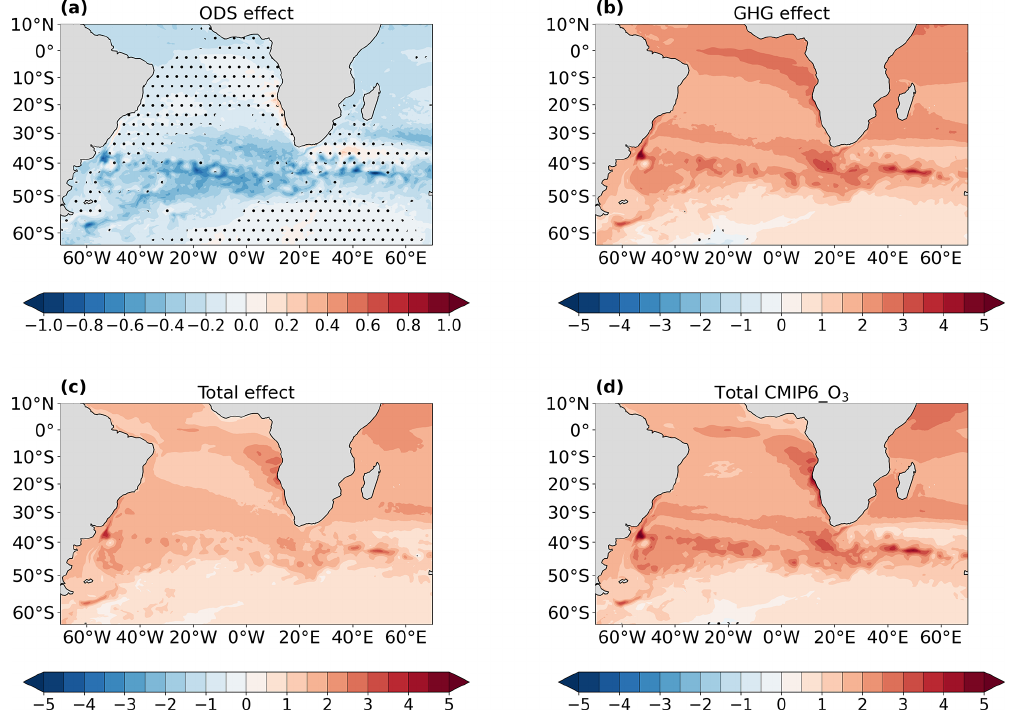
Figure 17. Changes in the SST ( ◦ C) for the region covered by the high-resolution nest (63 ◦ S–10 ◦ N and 70 ◦ W–70 ◦ E): effect of ozone recovery (a) , effect of GHGs (b) , total effect in INTERACT_O 3 (c) , and total effect in CMIP6_O 3 (d) . The stippling masks regions where the changes are not significant at the 95% confidence interval based on a two-tailed t